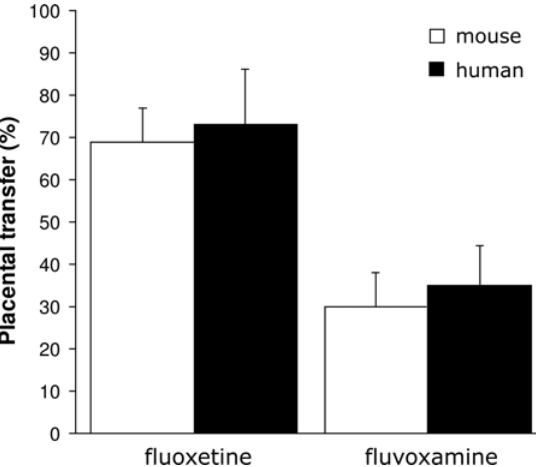
Figure 1. Placental transfer of fluoxetine and fluvoxamine in mouse (white bars) and human (black bars) presented as mean 6 S.E.M. Fluoxetine showed a high placental transfer in both mice (69%; N=4) and human (73%; N=6), while fluvoxamine has a low placental transfer in mice (30%; N=4) and human (35%; N=2).